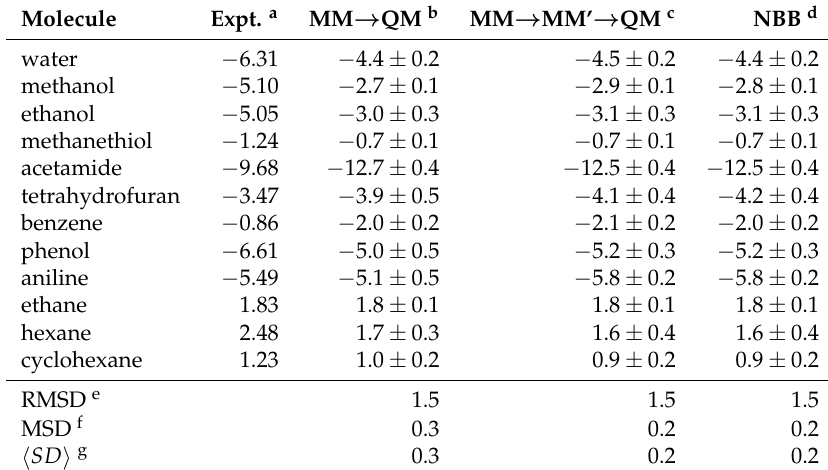
Table 5. Comparison of the three different approaches to obtain QM/MM hydration free energies with OM2 and the fixed charge force